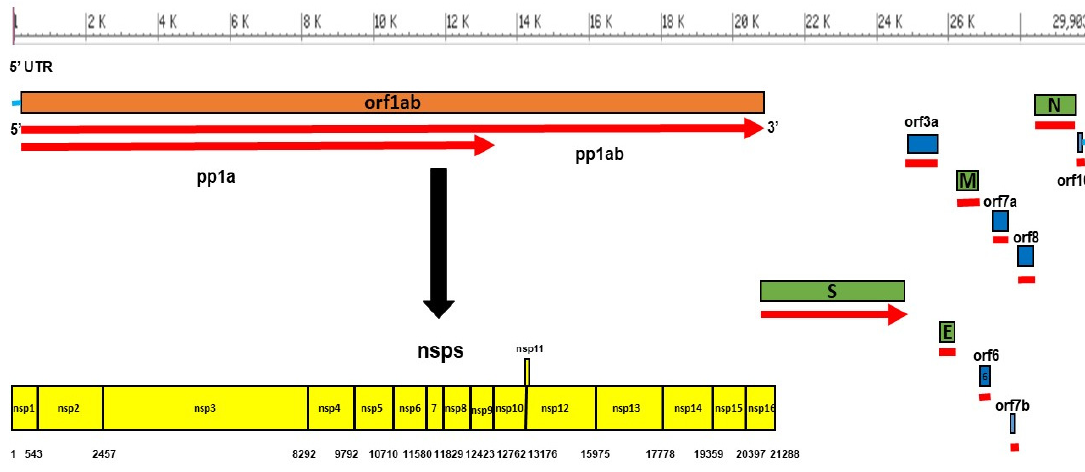
Figure 1. Genome organization of SARS CoV-2 and its encoded proteins. The orf1ab gene constitutes two-thirds of the genome, encodes a total of 16 non-structural proteins (NSPs) within the pp1ab gene, as shown in yellow, which are nsp1 (180 aa), nsp2 (638 aa), nsp3 (1945 aa), nsp4 (500 aa), nsp5 (306 aa), nsp6 (290 aa), nsp7 (83 aa), nsp8 (198 aa), nsp9 (113 aa), nsp10 (139 aa), nsp11 (13 aa), nsp12 (932